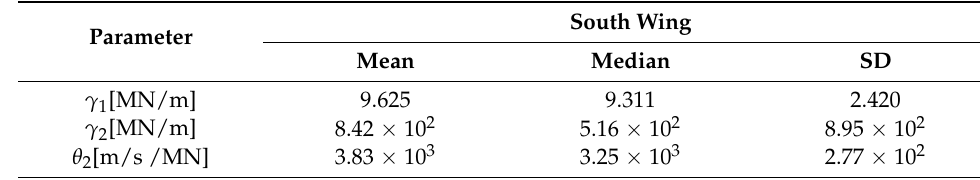
Table 2. The correlation matrix between model parameters for all results. Parameter (from Each Test)